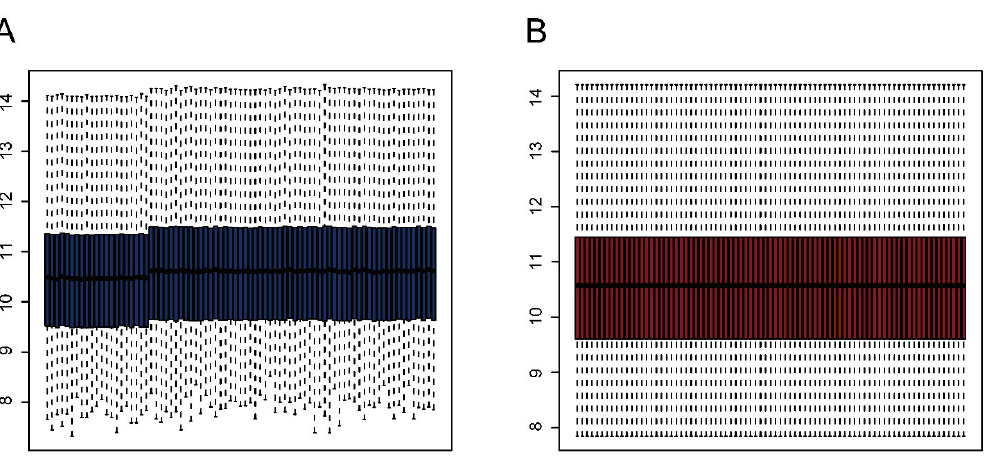
Int. J. Mol. Sci. 2023 , 24 , 2367